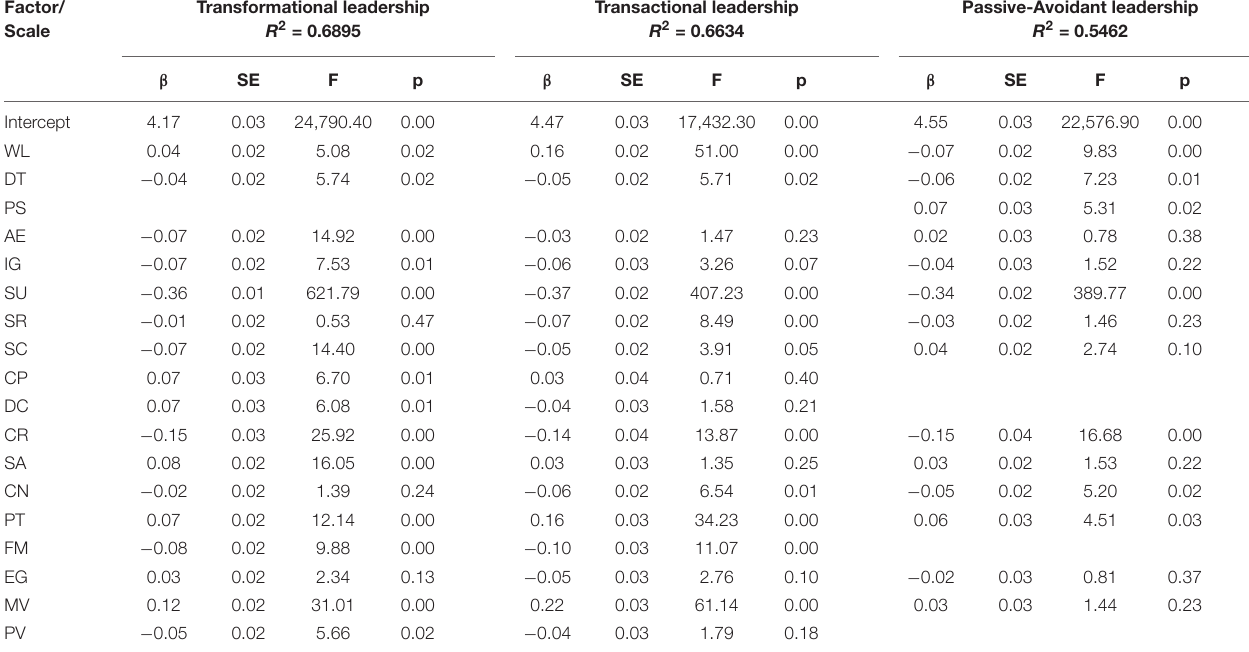
TABLE 6 | Predicting different leadership styles with the MMP ( n =430). Factor/ Scale